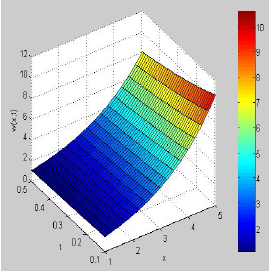
Fig. 7: Surface graph of w ( x , t ) of eq. (8.4), when α = 0.8